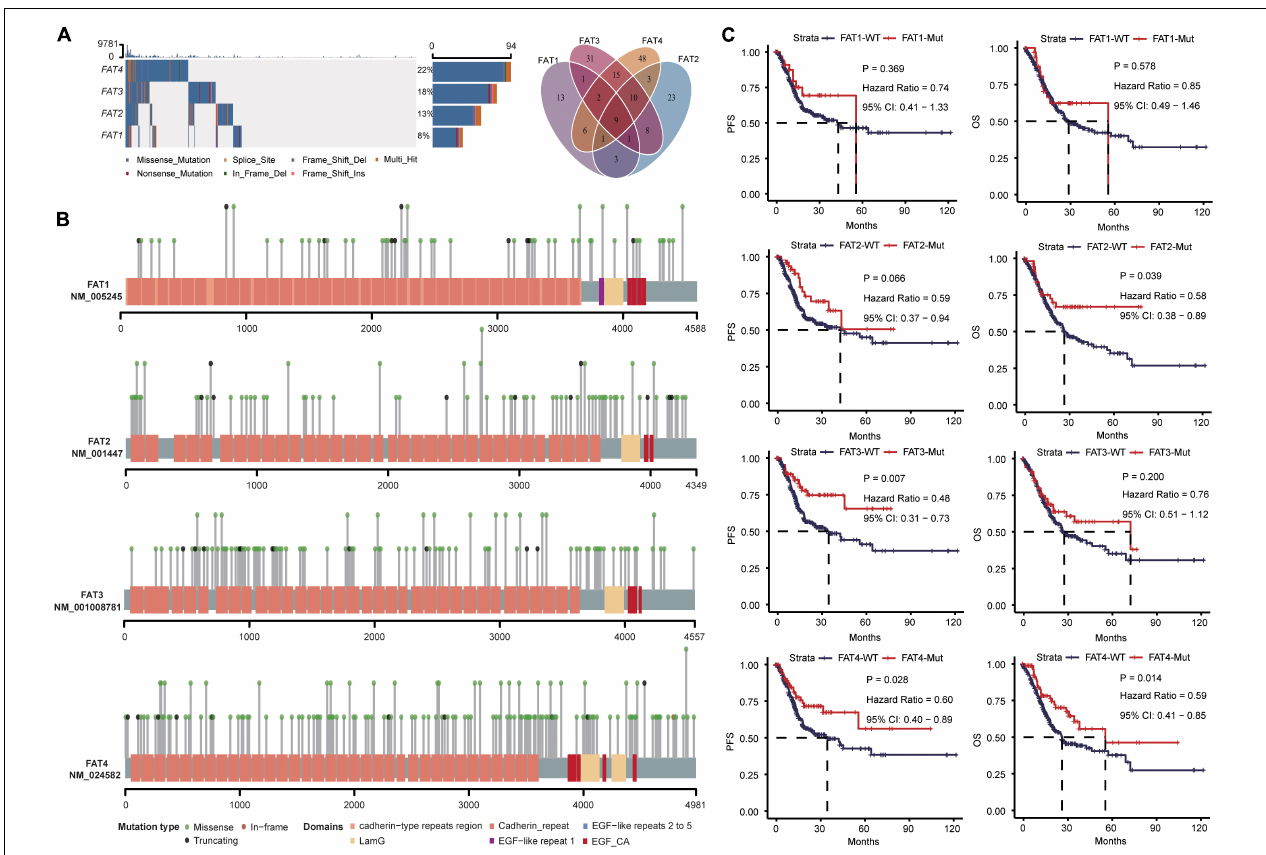
FIGURE 1 | Mutations of FAT family members and its relationship with prognosis. (A) The mutational landscape of four FAT genes is showed (left). The Venn diagram showing the co-mutation numbers among different FAT members (right). (B) Display of protein functional domains and mutation sites of FAT family members in this study. (C) Kaplan-Meier analysis of progression-free survival (PFS) and overall survival (OS) in STAD patients with FAT1 , FAT2 , FAT3 , or FAT4 mutations,